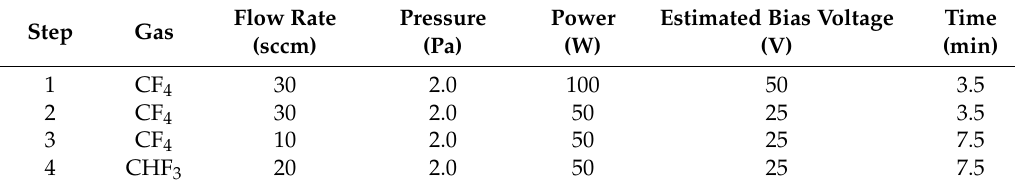
Table 3. Effects of each RIE step.